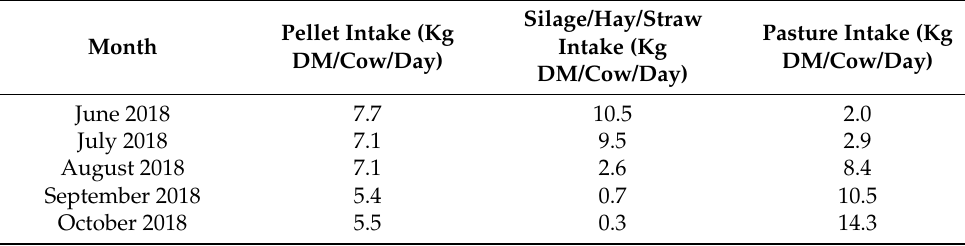
Table 1. Pellet, silage/hay/straw and estimated pasture intake for the entire herd from